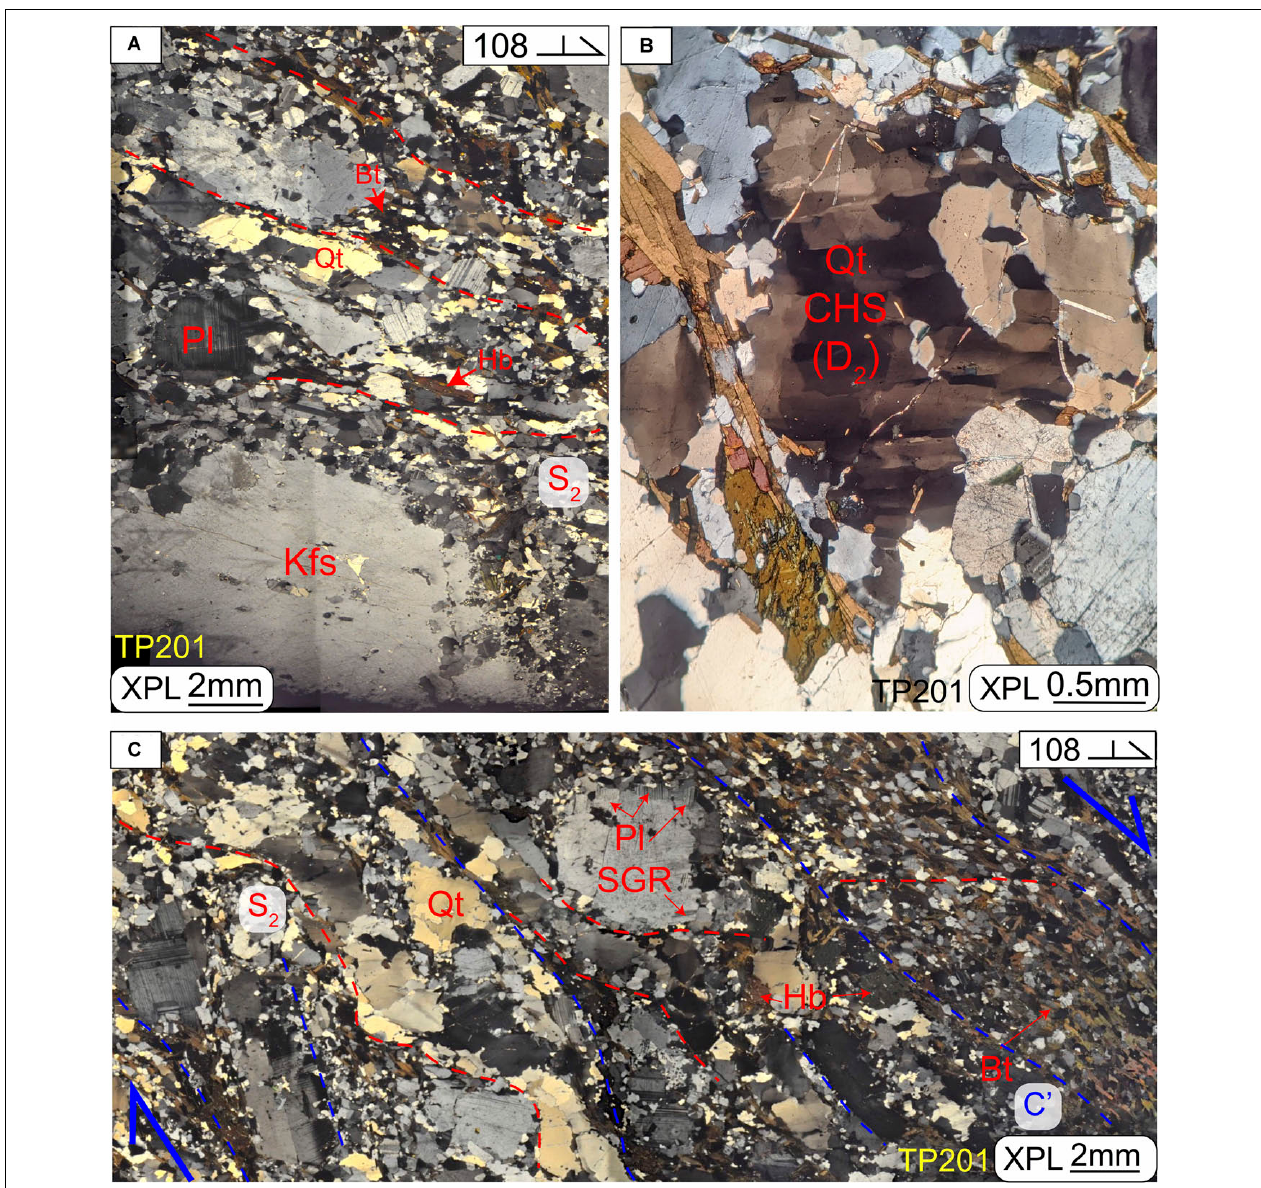
FIGURE 10 | Microphotographs showing microstructures and petrographic relationship of D 2 and D 3 . (A) S 2 foliation defined by alignment of biotite, elongated quartz, feldspar, and hornblende. The K-feldspar porphyroclasts are mainly deformed by SGR and BLG with myrmekite along the margin. The plagioclases are recrystallized with granoblastic polygonal texture and SGR within the microlithon domain. The quartzs are deformed mainly by grain boundary migration (GBM). The deformation mechanisms of these quartz-feldspar aggregates suggest upper amphibolite facies condition. (B) Chessboard extinction of quartz illustrating the deformation temperature is > 630 ◦ C. (C) S 2 foliation sheared by C’ fabric with normal sense of shear. D 2 -domain is defined by the coarser grain-sizes of quartz-feldspar aggregates with granoblastic interlobate texture and preserved chessboard extinction within quartzs. D 3 -domain (C’ fabric) is defined by the finer recrystallized quartz-feldspar aggregates and biotite folia due to the shearing-induced grain size